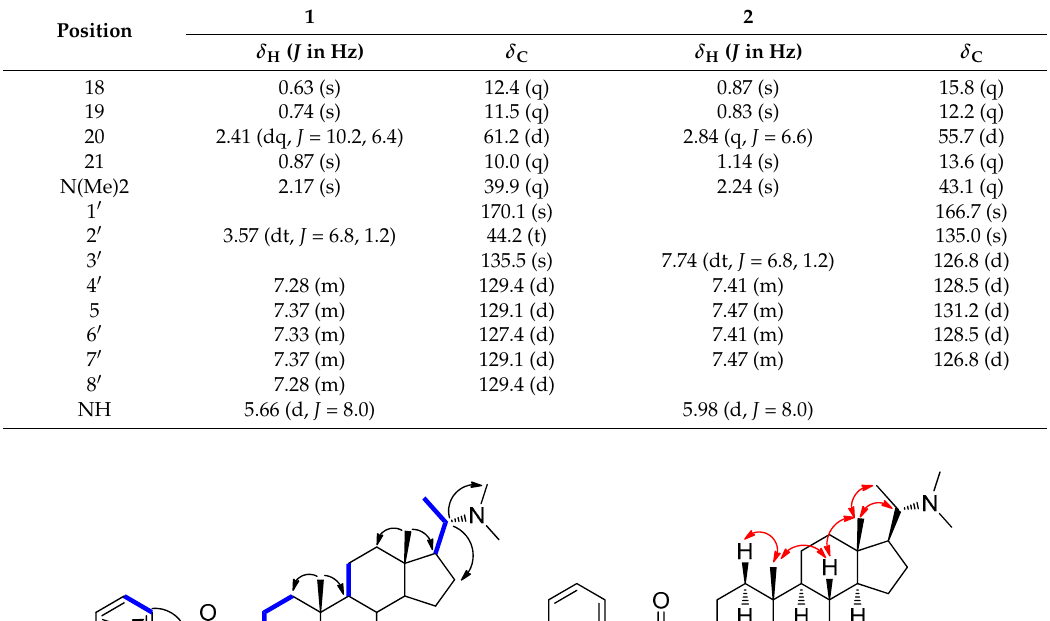
Figure 2. Key 1 H, 1 H-COSY (